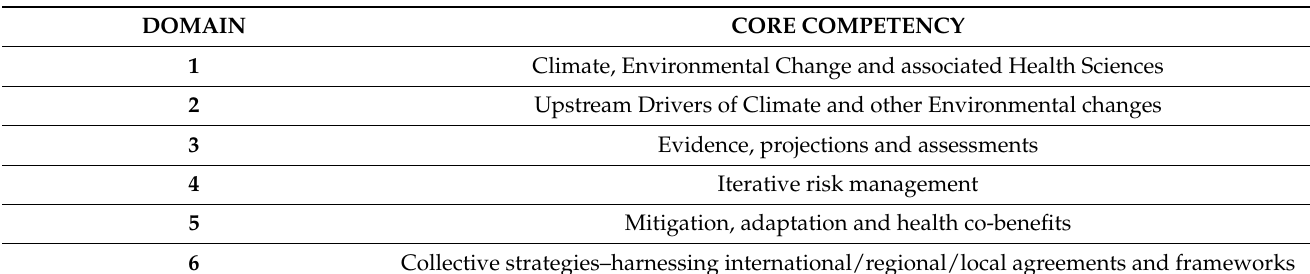
Table 1. Core Climate and Environmental Change for Health Competencies for education and training of Health Workers.